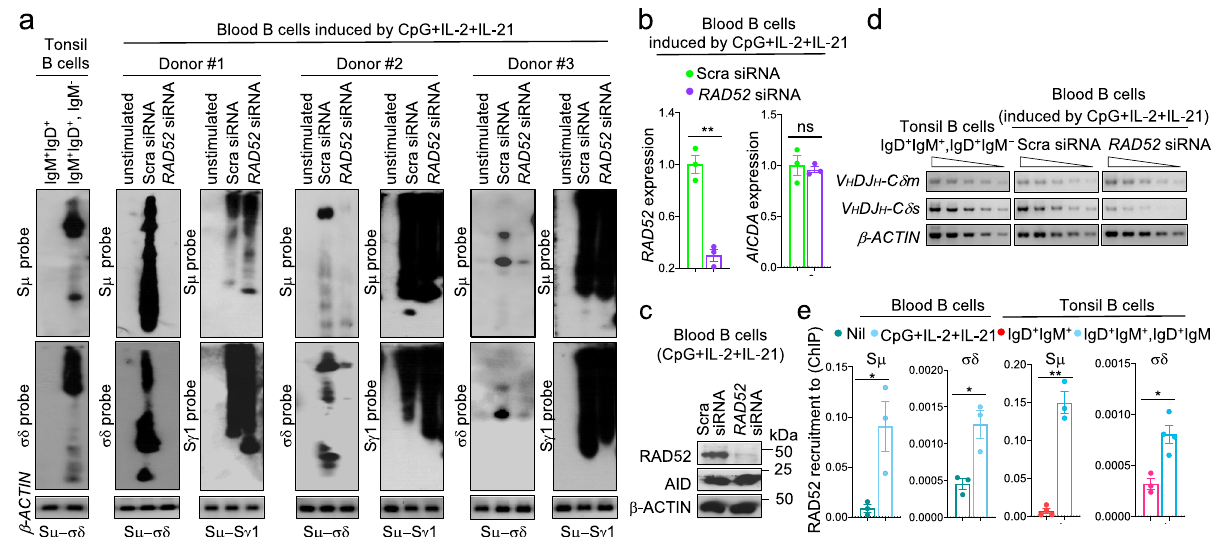
Fig. 8 RAD52 is required for S μ – σδ DNA recombination in human B cells. a Human blood naïve IgM + IgD + B cells were transfected with speci fi c RAD52 siRNA or scrambled (Scra) siRNA and stimulated by CpG plus IL-2 and IL-21. Recombined S μ – σδ and S μ – S γ 1 DNA in the transfected B cells 120 h after RAD52 siRNA transfection, as well as S μ – σδ DNA in tonsil IgM – IgD + and blood naive IgM + IgD + B cells were analyzed by nested PCR using forward I μ and reverse C δ or S γ 1 primers followed by Southern-blotting using indicated speci fi c probes. Data are from three independent experiments. b Expression of RAD52 and AICDA transcripts was analyzed 48 h after RAD52 siRNA or Scra siRNA transfection by qRT-PCR and normalized to HPRT expression. Data are mean ± SEM of three independent experiments. ** p < 0.01, ns: not signi fi cant (unpaired two-tailed t -test). c Expression of RAD52 and AID proteins were analyzed 72 h after RAD52 siRNA or Scra siRNA transfection by speci fi c Western blotting. Data are representative of three independent experiments. d Expression of V H DJ H − C δ m and V H DJ H − C δ s transcripts as analyzed by semi-quantitative RT-PCR with of serial two-fold dilution of cDNA templates. Data are representative of three independent experiments. e RAD52 is recruited to σδ region DNA in human B cells undergoing CSR to IgD. Recruitment of RAD52 to S μ and σδ region DNA in human blood naive IgM + IgD + B cells stimulated for 120 h with CpG plus IL-2 and IL-21, as analyzed by speci fi c ChIP- qPCR. Data are mean ± SEM of three or four independent experiments. * p < 0.05, ** p < 0.01 (unpaired two-tailed t -test). Source data are provided as a Source Data fi le.